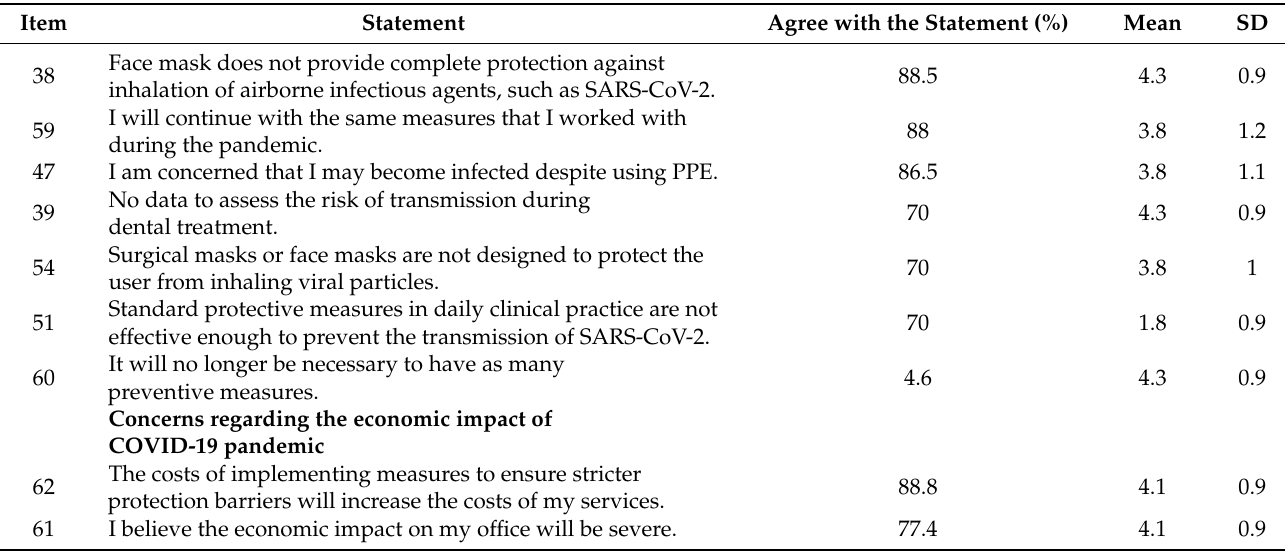
Table 7. Concerns regarding the COVID-19 pandemic and the effectiveness of preventive measures against its transmission. Item Statement Agree with the Statement (%) Mean